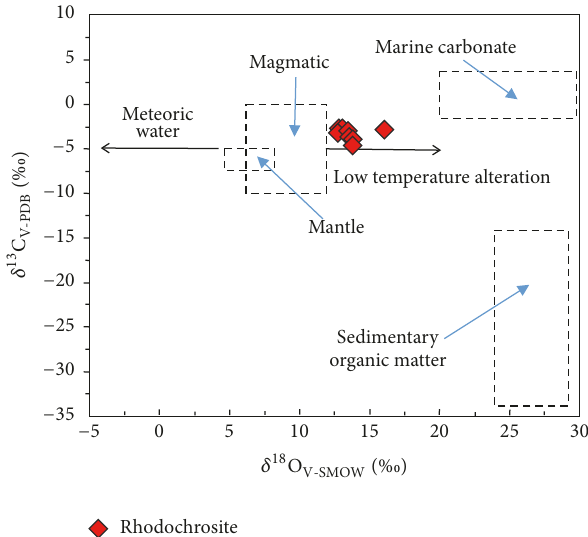
Figure 14: 𝛿 18 O versus 𝛿 13 C diagram of rhodochrosite from the Zhijiadi deposit. The base map is from [36,